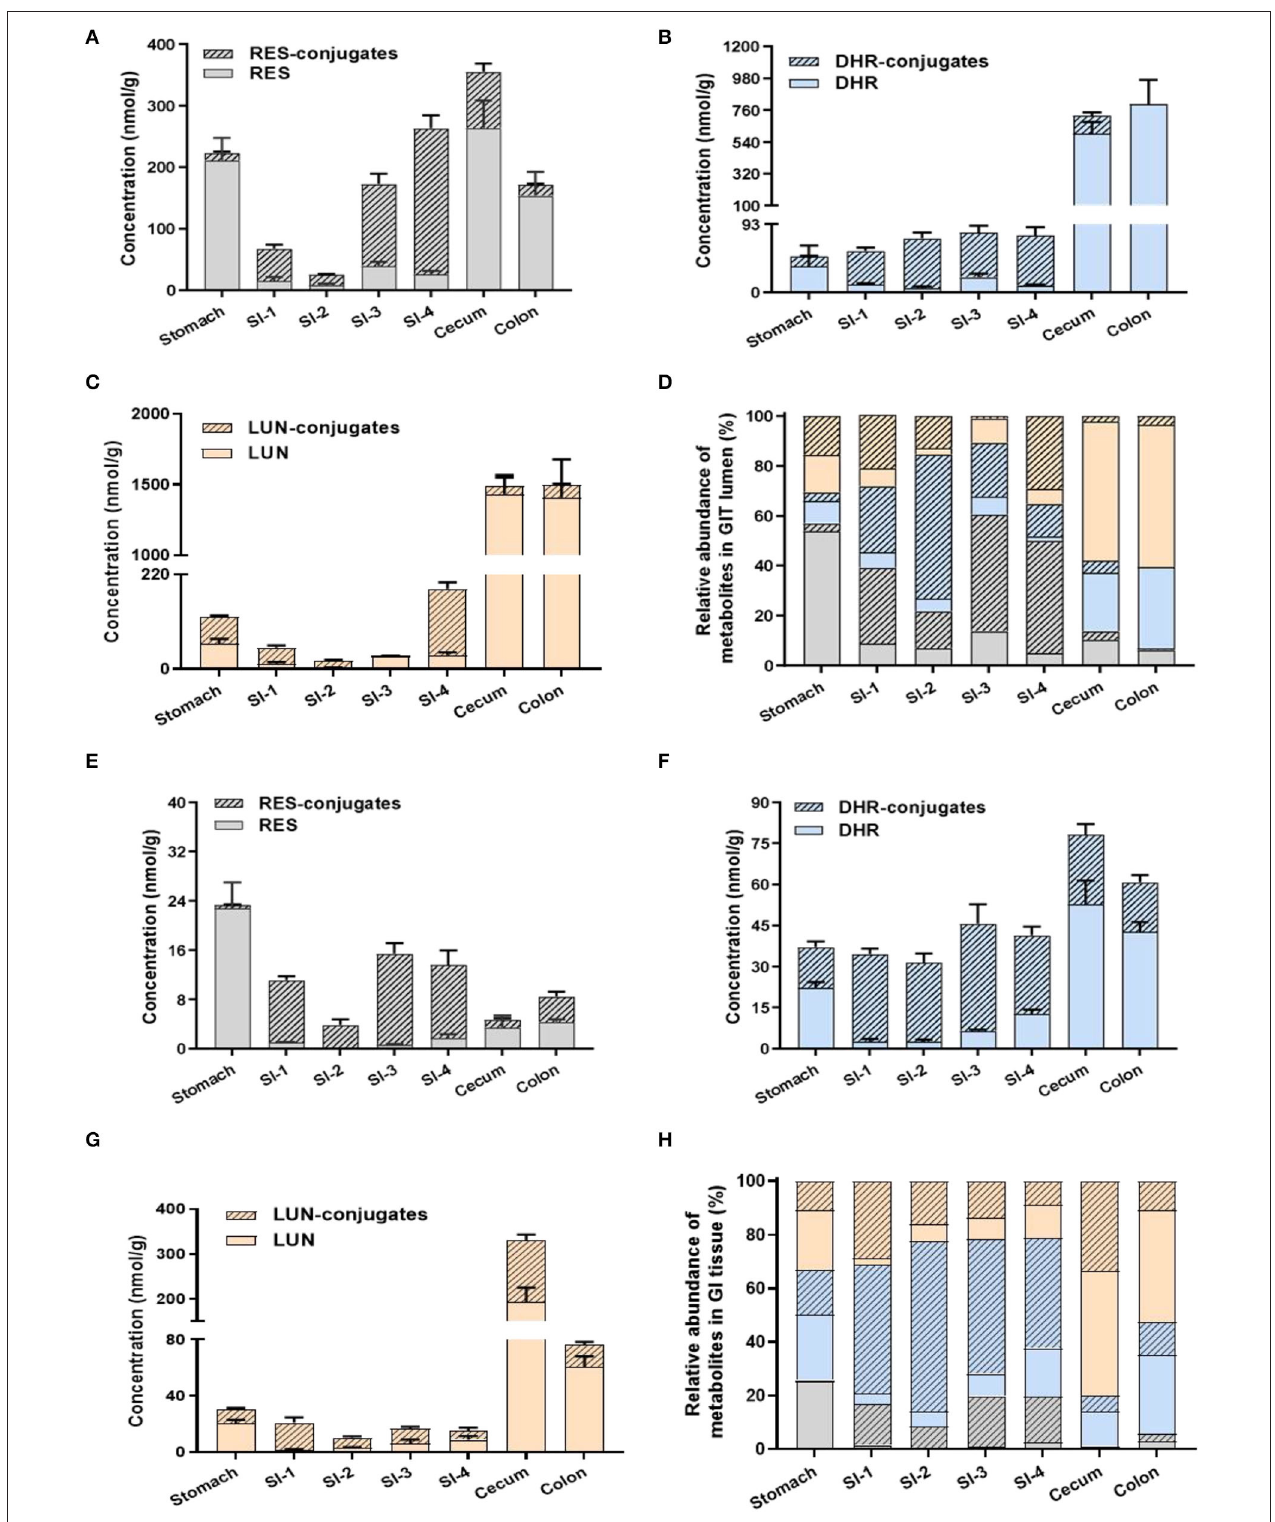
FIGURE 3 | Levels of RES metabolites in gastrointestinal digesta and tissues. Concentrations of RES, DHR, LUN, and their corresponding conjugates in digesta (A–C) . Relative abundance of RES metabolites in digesta (D) . The concentration of RES, DHR, LUN, and their corresponding conjugates in GIT tissues (E–G) . Relative abundance of RES metabolites in GIT tissues (H)